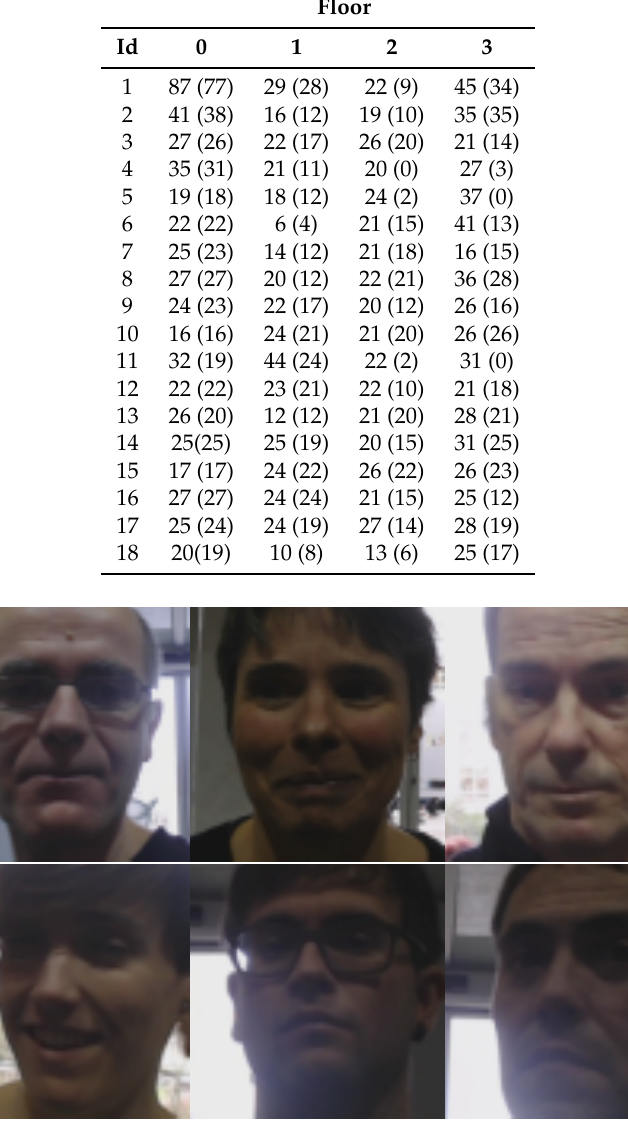
Figure 6. Examples of normalized detected faces, for different identities, after weak alignment and cropping of a sample per identity captured on Floor 0. Challenging pose and illuminations variations are